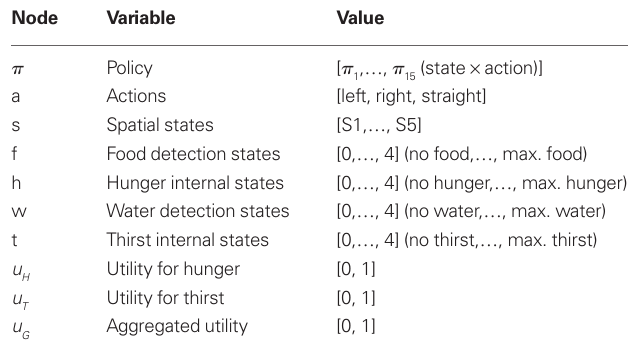
Table 3 | List of variables used in Figure 3.